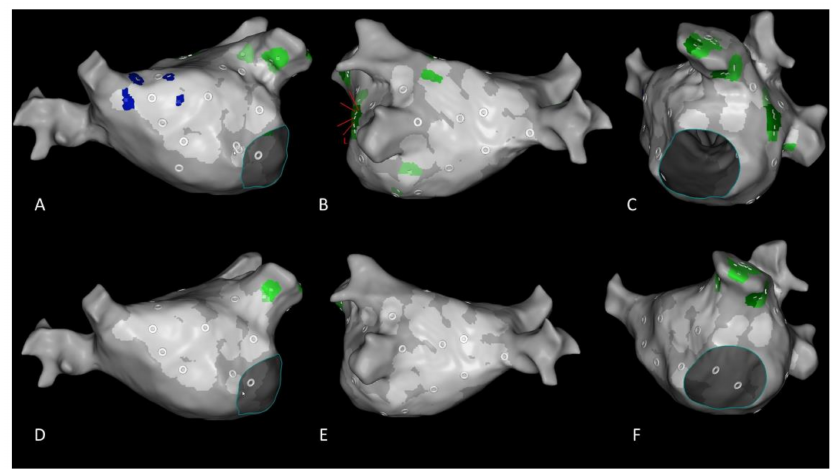
Figure 6. Representative image to demonstrate and the temporal stability of region of interests (ROIs) from CARTOFINDER mapping. Upper panels: Findings from CARTOFINDER mapping prior to ablation. Lower panels: Findings from CARTOFINDER mapping after ablation. ( A , C , D , F ) Persistent focal activity (green spots) in the left atrial appendage, independent of pulmonary vein isolation and left atrial substrate modification. ( A , D ) In contrast, the rotational activity (blue spots) disappeared after catheter ablation. ( B , E ) This was also the case for focal activity (green spots) around the left sided pulmonary